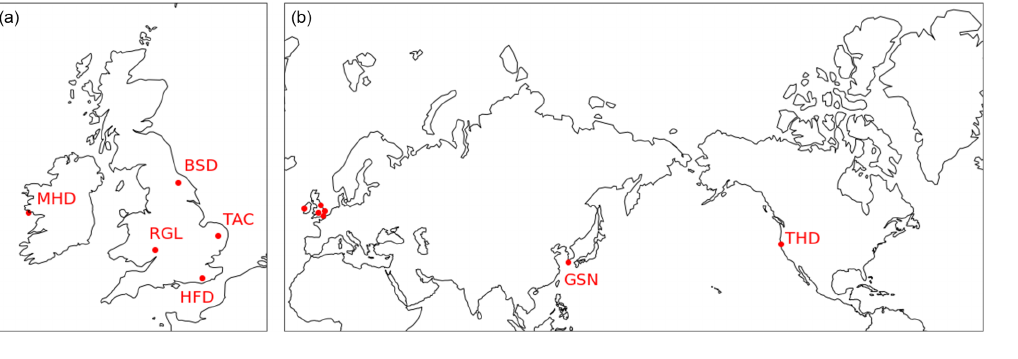
Figure 1. Measurement sites in (a) the UK and Ireland and (b) the rest of the world. Sensors are located at Mace Head (MHD, Ireland, 53.326 ◦ N, 9.904 ◦ W, inlet is 10ma.g.l. (metres above ground level)), Ridge Hill (RGL, UK, 51.997 ◦ N, 2.540 ◦ W, 90ma.g.l.), Bilsdale (BSD, UK, 54.359 ◦ N, 1.150 ◦ W, 250ma.g.l.), Heathfield (HFD, UK, 50.977 ◦ N, 0.230 ◦ E, 100ma.g.l.), Tacolneston (TAC, UK, 52.518 ◦ N, 1.139 ◦ E, 185ma.g.l.), Gosan (GSN, Korea, 33.292 ◦ N, 126.161 ◦ E, 10ma.g.l.), and Trinidad Head (THD, USA, 41.054 ◦ N, 124.151 ◦ W,